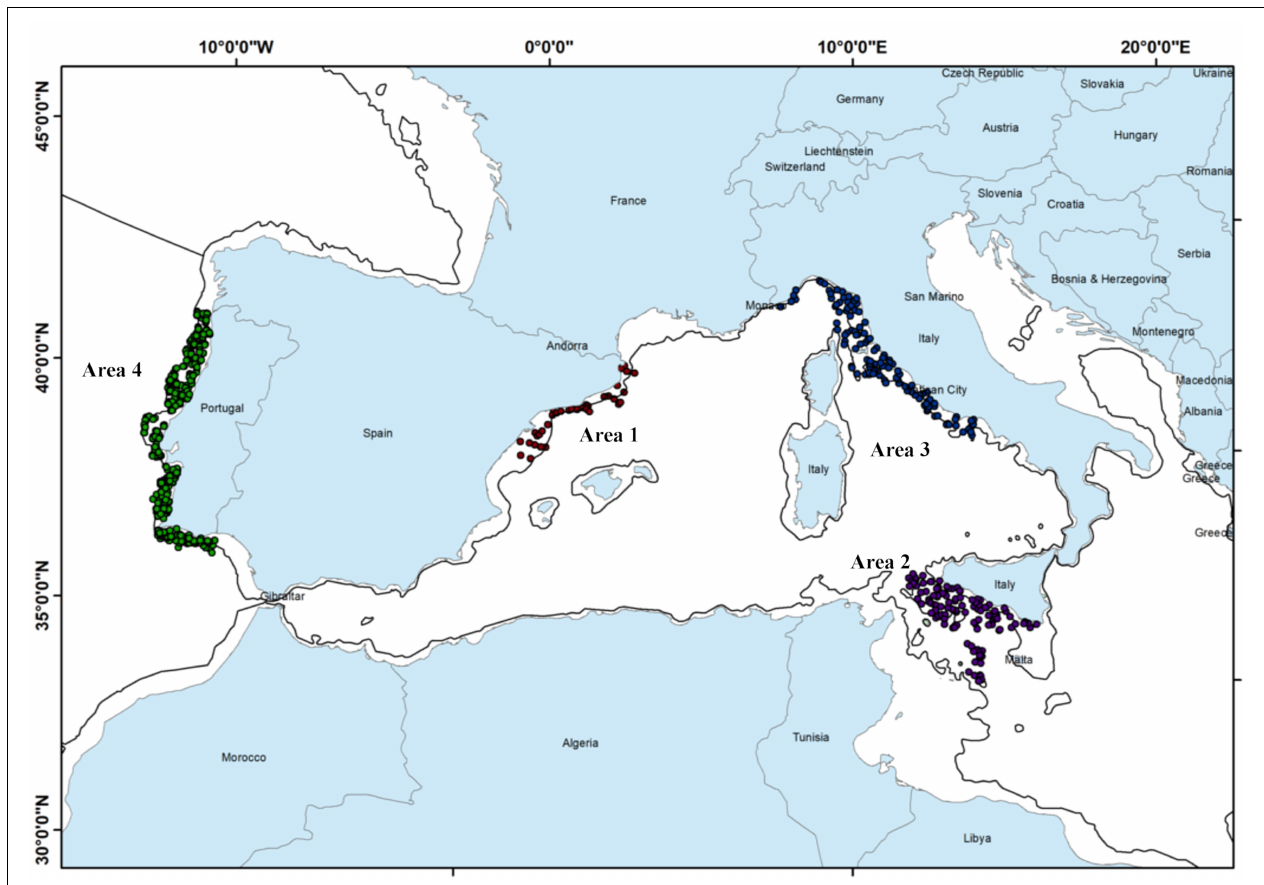
FIGURE 1 | Location of the study areas: Area 1 – Catalan Sea, Area 2 – Strait of Sicily, Area 3 – Ligurian and northern Tyrrhenian Seas, Area 4 – Portuguese area. Dots = hauls locations; Black line = 200 m depth.